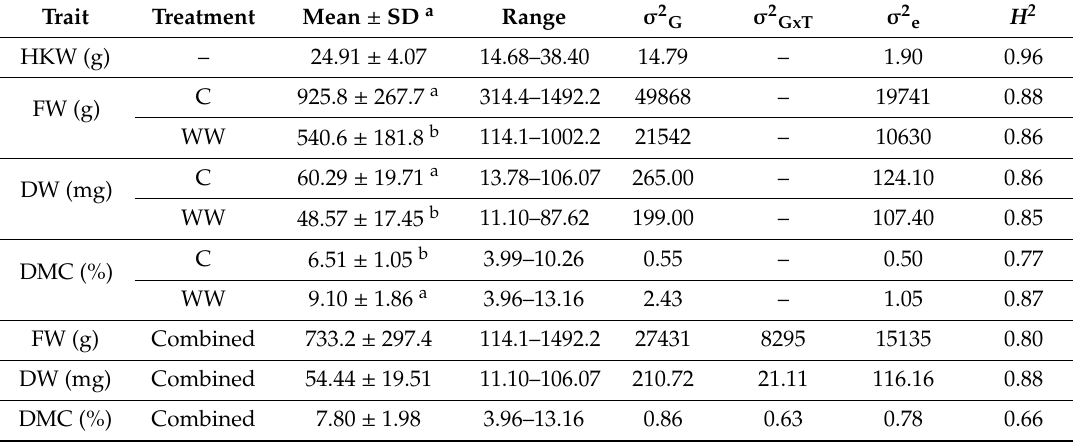
Table 1. Means ± standard deviations, ranges, variance components, repeatabilities, and heritabilities for hundred kernel weight (HKW) in grams and biomass traits fresh weight (FW) in grams, dry weight (DW) in milligrams, and dry matter content (DMC) as % of FW in control (C) and water withholding (WW) treatments. The values calculated within treatments are repeatabilities, while the values calculated across treatments represent heritabilities. Repeatability of HKW was calculated for year of seed multiplication